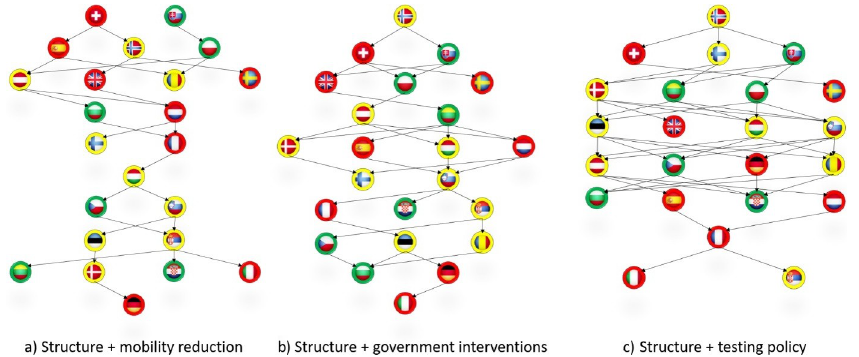
Fig 2. Hierarchical order of countries after adding different dimensions of the